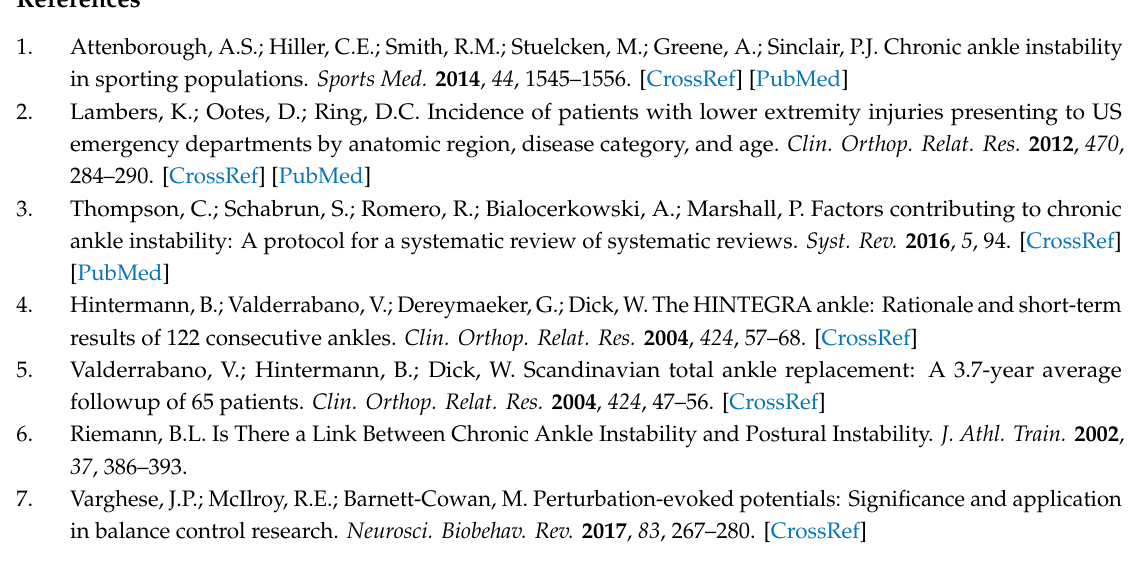
Table S1: Blinding and tolerability e ffi cacy survey